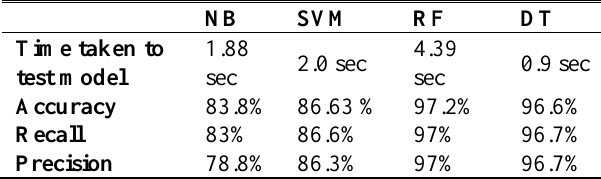
Table 9. Test Results of 07